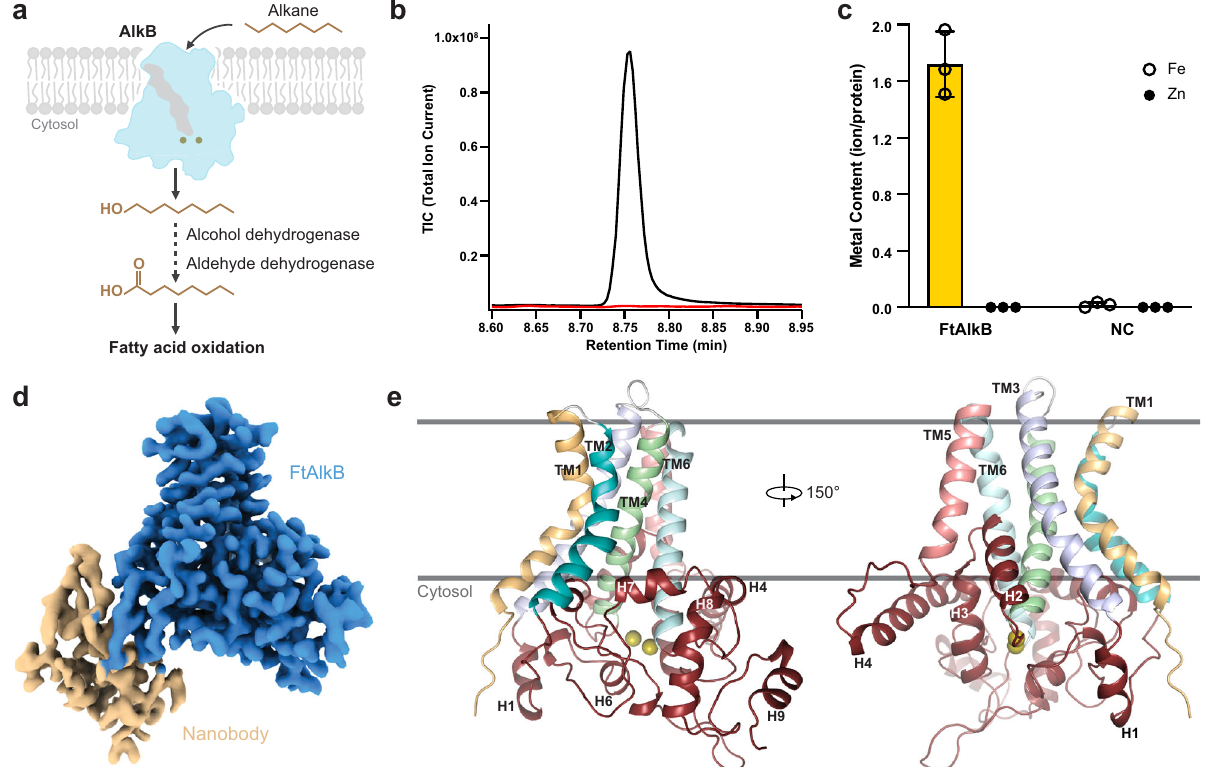
Fig. 1 | Functional characterization and structure of FtAlkB. a Key steps in the biologicaldegradationofalkanes.AlkBsinitiatealkanemetabolismbytransforming alkanes into alcohols. b Alkane hydroxylation activity of FtAlkB on octane. A representative GC-MS pro fi le of the octanol peak of FtAlkB (black) and negative control without FtAlkB (red). Experiments were repeated three times indepen- dently and similar results were observed. The activity of the puri fi ed protein